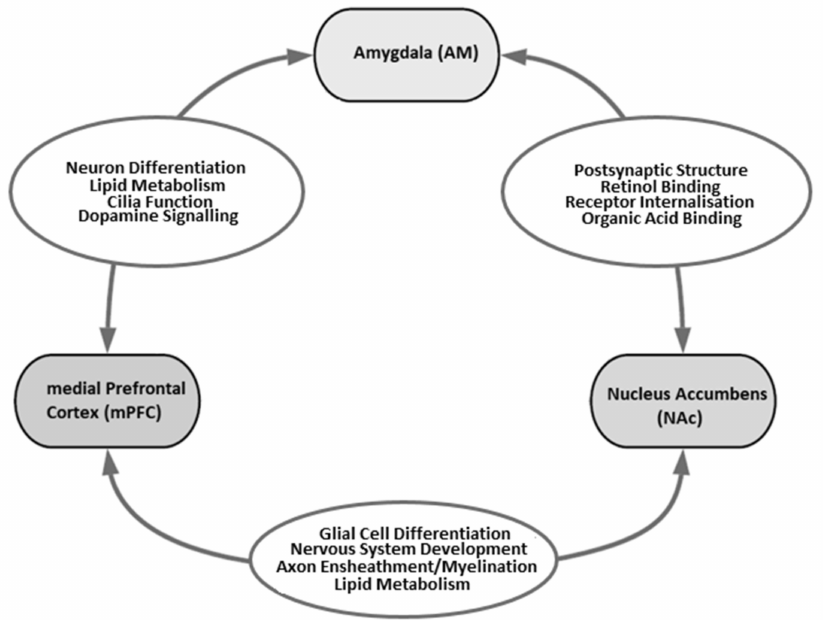
Figure 2. Overlapping DEGs between studies were subjected to GO analysis. GO terms were considered significant at FDR < 0.05. The ovals between two brain regions highlight the GO terms relevant to neurodevelopment that were enriched for DEGs found in both of those brain